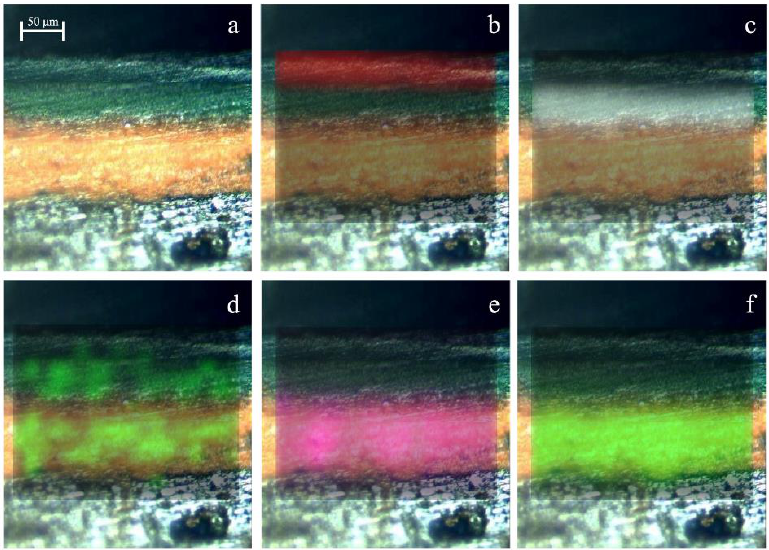
Figure 2. Raman image of a cross-sectional sample (sample SUBS-1a) (50×) collected from the railing piece ( a ) and its molecular composition: phthalocyanine green ( b ), phthalocyanine blue ( c ), yellow azo pigment ( d ), barium sulfate ( e ) and minium ( f ).